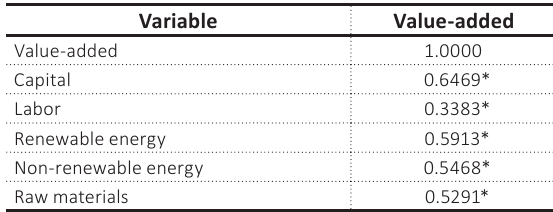
Table 2. Summary of correlations between the study variables